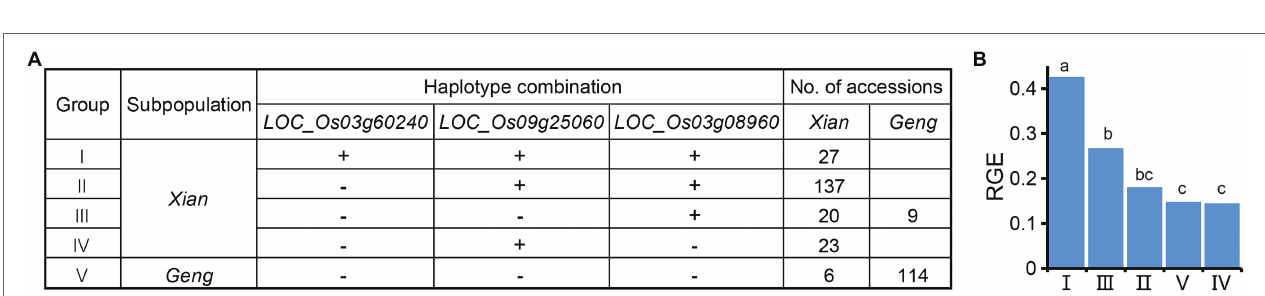
FIGURE 8 | Optimal alkali-tolerant haplotype combination of candidate genes. (A) Combined haplotypes of LOC_Os03g60240 , LOC_Os09g25060 , and LOC_ Os03g08960 . “+” and “ − ” represent favorable and inferior haplotypes, respectively. (B) Comparison of the RGE among different haplotype combinations. Different letters above each histogram indicate significant differences at p < 0.05 (Least Significant Difference